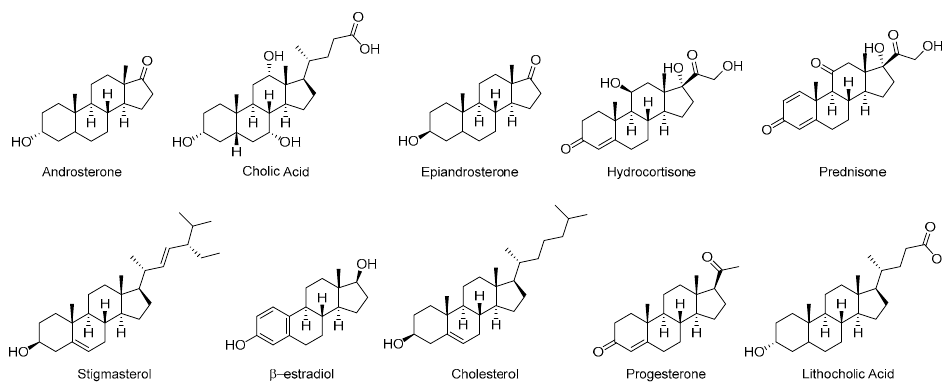
Figure 1. Chemical structures of the steroids used as chiral dopants.